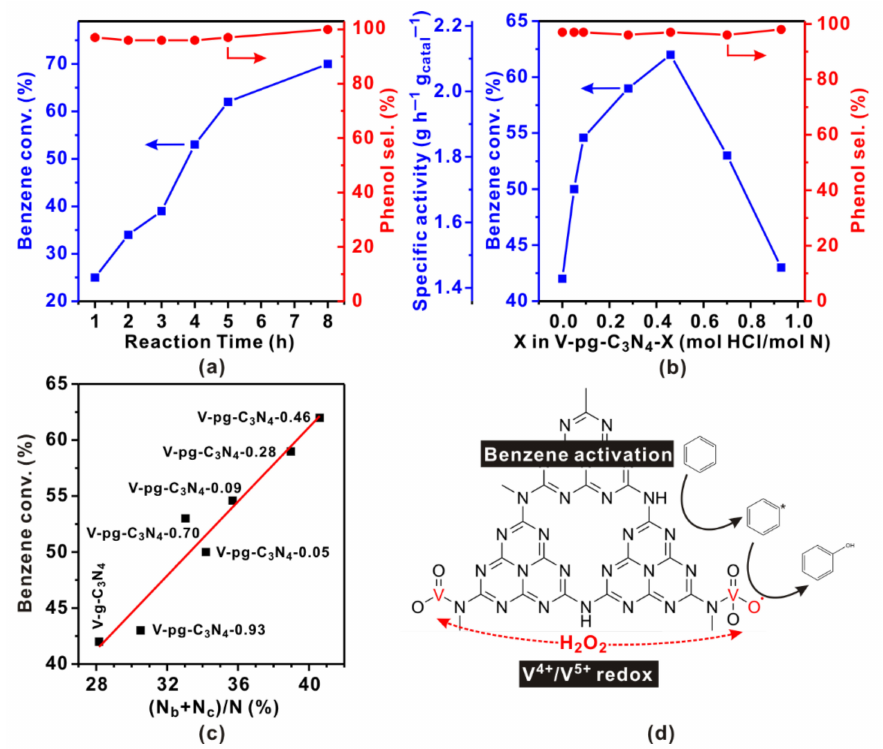
Figure 4. ( a ) Catalytic activity as a function of reaction time over V-pg-C 3 N 4 -0.46; ( b ) Catalytic activity (5 h) as a function of the HCl amount used in the preparation of V-pg-C 3 N 4 -X. Reaction conditions: benzene (1.0 mL, 11.3 mmol), hydrogen peroxide (30 wt%, 3.0 mL, 29.6 mmol), acetonitrile (4.8 mL), acetic acid (1.2 mL), catalyst (0.06 g, 0.022 mmol V), T = 333 K. ( c ) Benzene